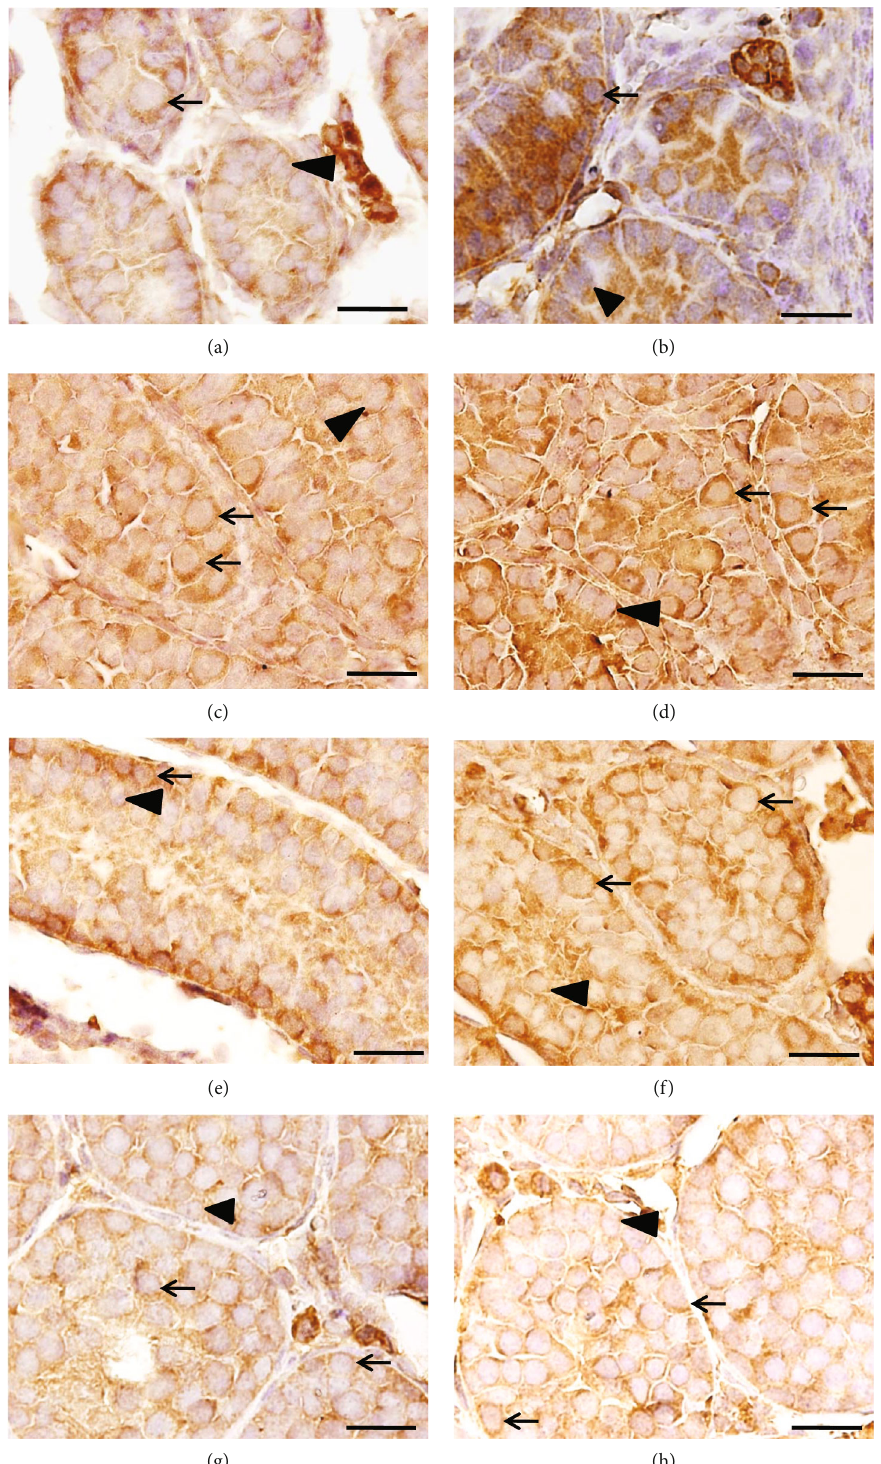
Figure 5: Seminiferous cords/tubules of mice: (a) control of 3 dpp, (b) the nicotine group of 3dpp, (c) control of 7dpp, (d) the nicotine group of 7 dpp, (e) control of 10 dpp, (f) the nicotine group of 10dpp, (g) control of 16 dpp, and (h) the nicotine group of 16dpp. Immunoreactivity of α 7-nAChR in germ cells (arrow), as well as in Sertoli cells (arrowhead). Higher OD in germ cells of nicotine groups of 3, 7, and 10dpp can be observed. In the animals of 16dpp, the OD between both groups is not di ff erent. Immunohistochemical study: bar scale: 20 μ